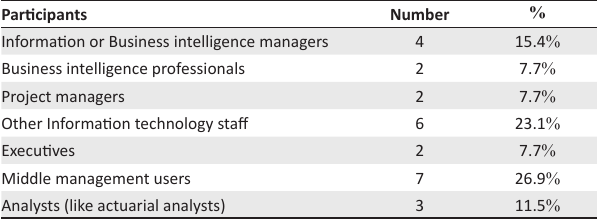
TABLE 1: Summary of the participants ( N = 26). Participants